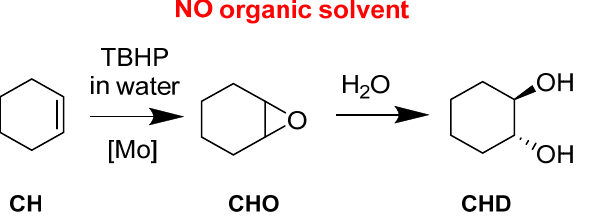
Figure 12. Organic solvent-free cyclohexene epoxidation and subsequent ring-opening with water.